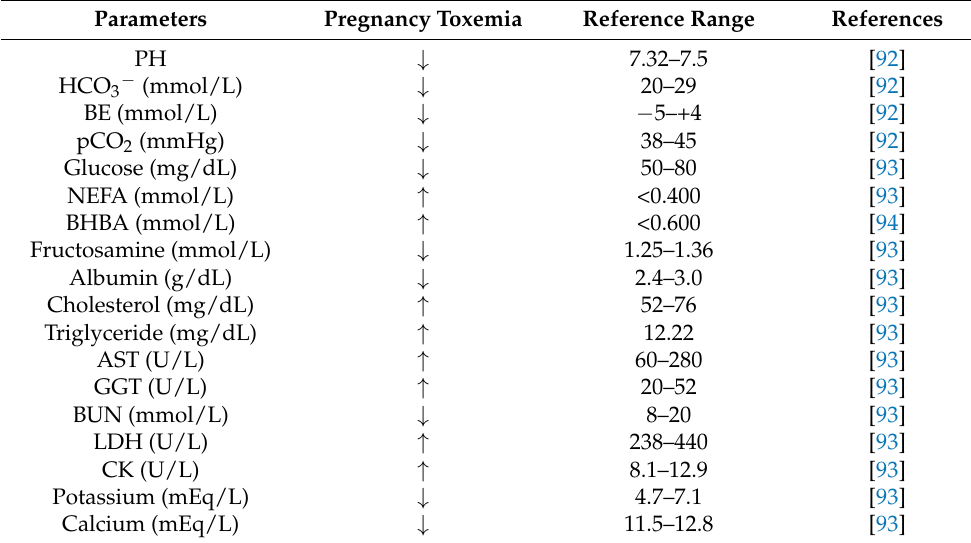
Table 2. Changes in biochemical parameters during pregnancy